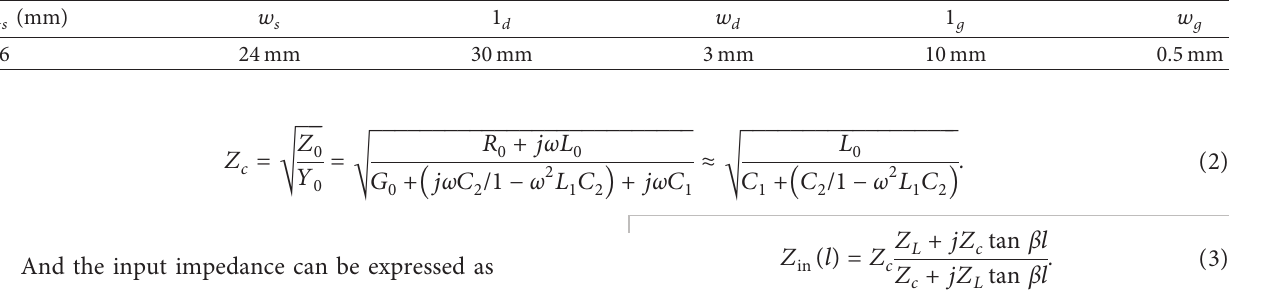
Table 2: Parameters for the proposed